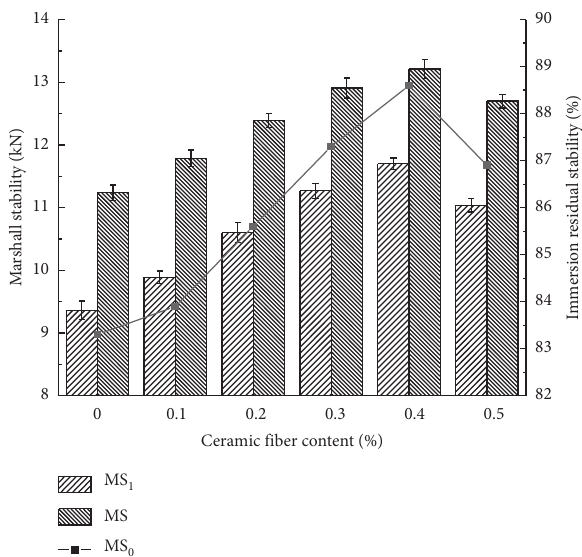
Figure 10: Results of Marshall immersion